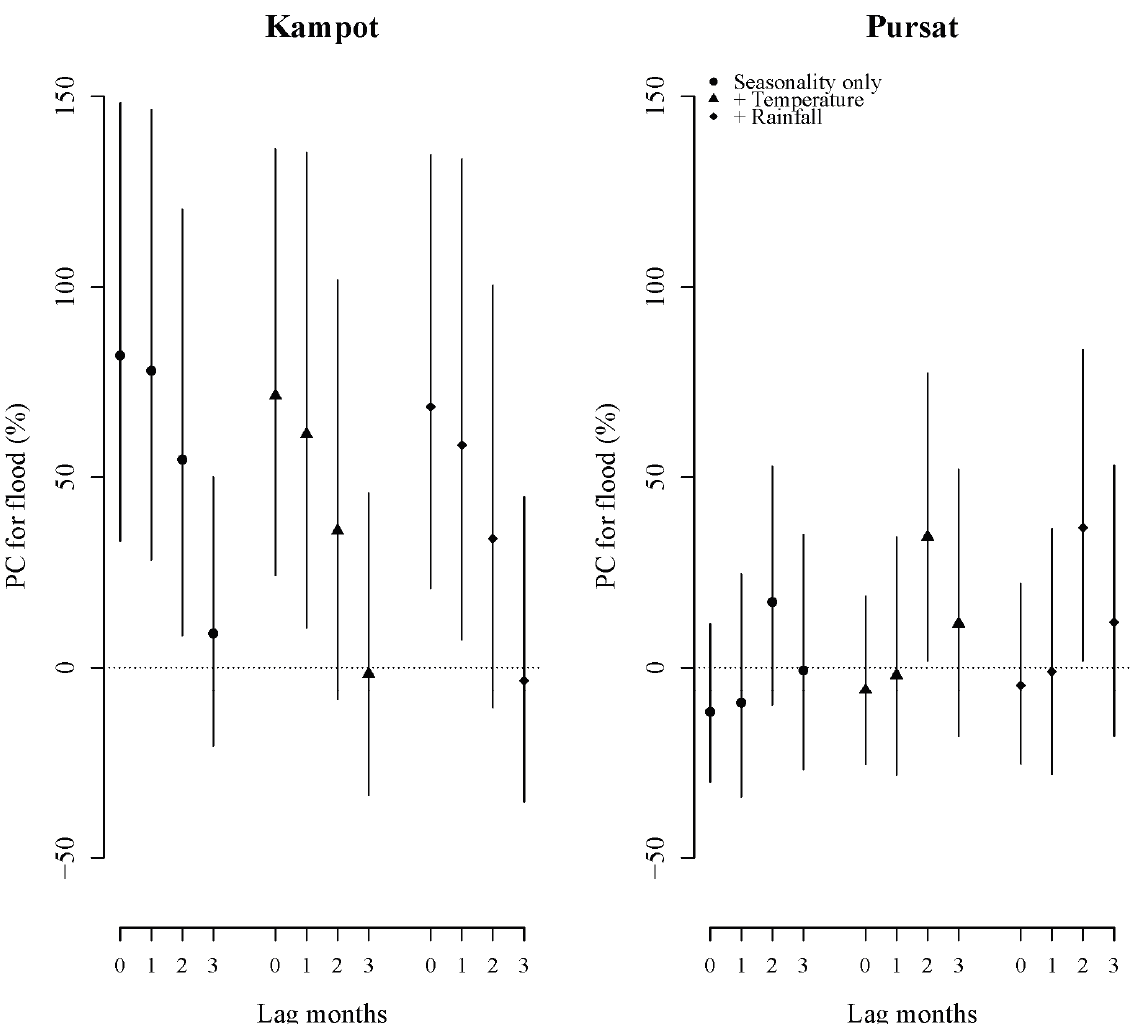
Figure A3. Flood effects on diarrhoea by distributed lag models in two